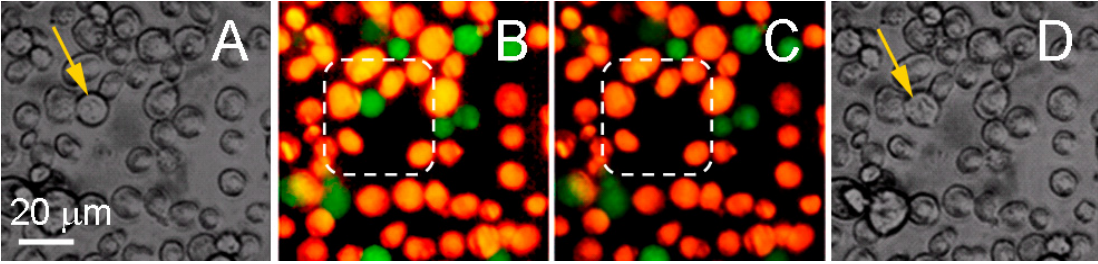
Figure 11. Bright field image and calceins fluorescence of prostate cancer C4-2B (green) and stromal HS-5 (orange) cells before ( a , b ) and 60 s after ( c , d ) exposure to a pair of laser pulses (532 nm and 787 nm) that selectively generated a cell damaging PNB causing fading of green fluorescence due to leaking of green calcein out through the disrupted membrane. Dashed line shows the area that was exposed to the laser pulses. Bright field images show the disruption of the target cell